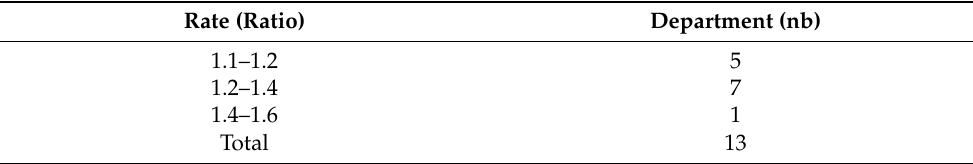
Table 9. The number of departments with land-consumption rate class in Houet, Burkina Faso. Rate (Ratio)